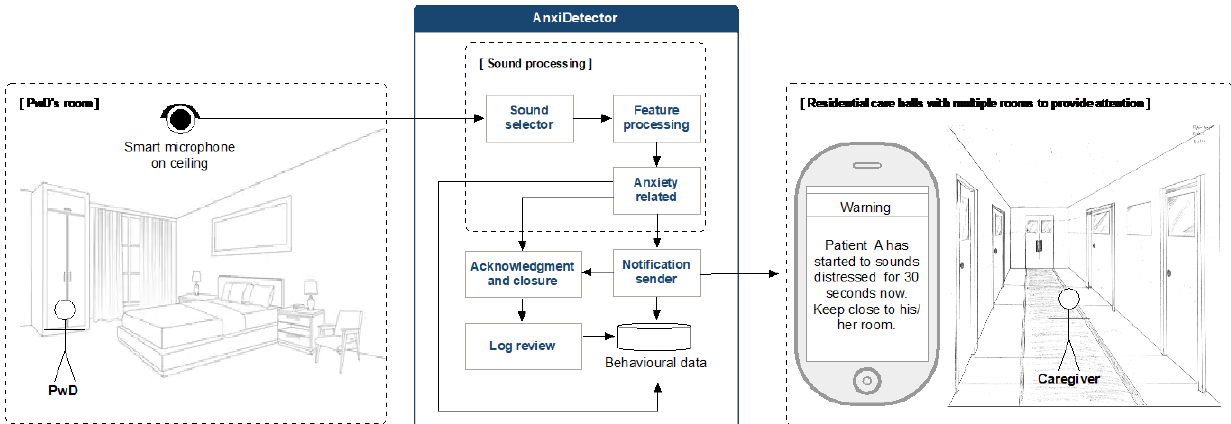
Figure 1 . AnxiDetector architecture consisting of six components to collect, filter, and select audio features from the PwD’s daily life environment (left side of diagram). AnxiDetector automatically monitors anxiety episodes and triggers a notification to caregivers through their smartphone or smartwatch (right side of